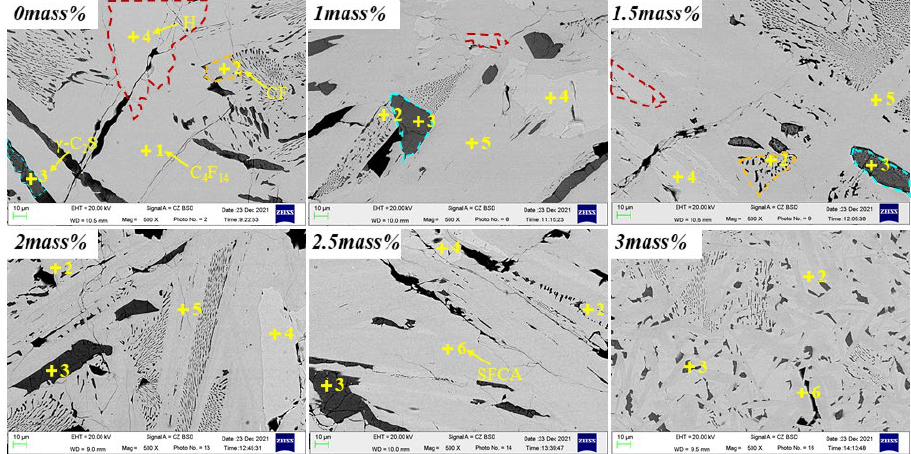
Figure 4. SEM photos of the samples cooled at 0.02 °C/s.